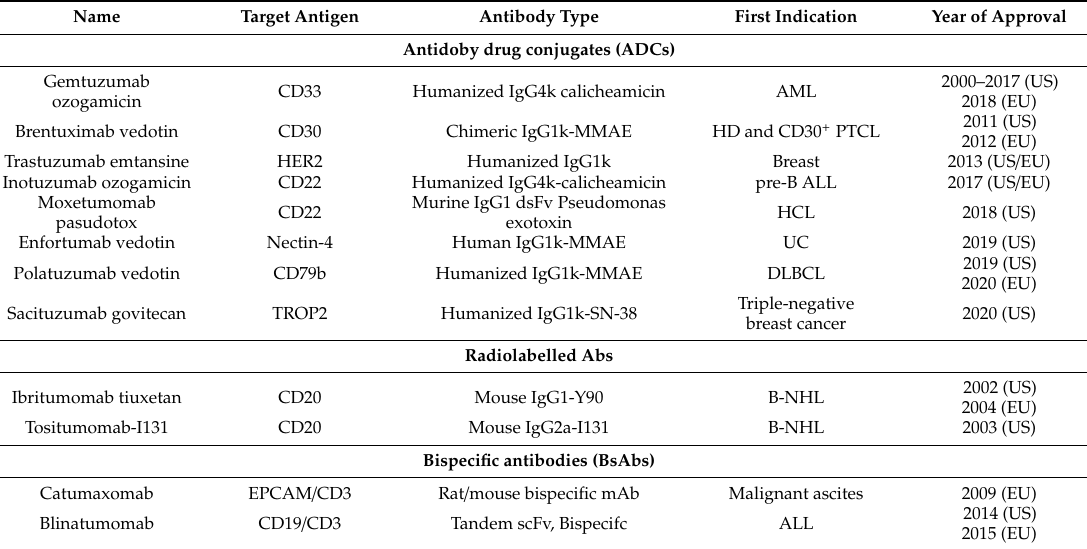
Table 3. Approved anti-cancer antibody conjugated to drugs, radionuclide and